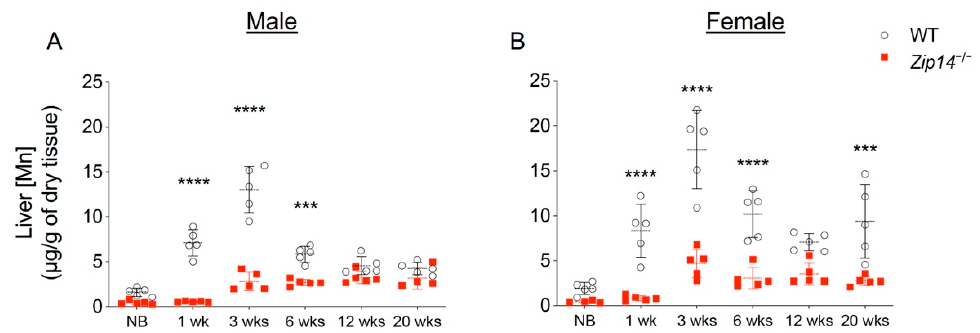
Figure 3. Liver manganese in mice from different age groups of WT and Zip14 − / − mice. Liver manganese concentrations measured by ICP-MS in ( A ) male and ( B ) female mice at newborn (NB), one week (1 week), three weeks (3 weeks), six weeks (6 weeks), twelve weeks (12 weeks) and twenty weeks (20 weeks) of age ( n = 4–5/group). Data were expressed as mean ± S.D. and statistical analysis was performed using two-way ANOVA, followed by the Bonferroni post-hoc test to compare results of WT and Zip14 − / − mice from the same age group. *** p < 0.001; **** p < 0.0001.